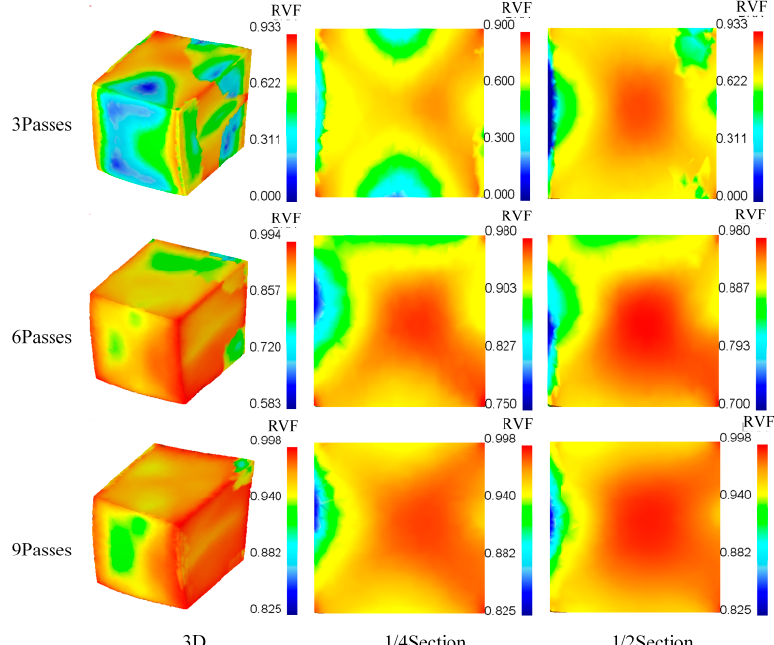
Figure 14. Forging from three to nine passes for dynamic recrystallization volume fraction cloud image at 900 °C.